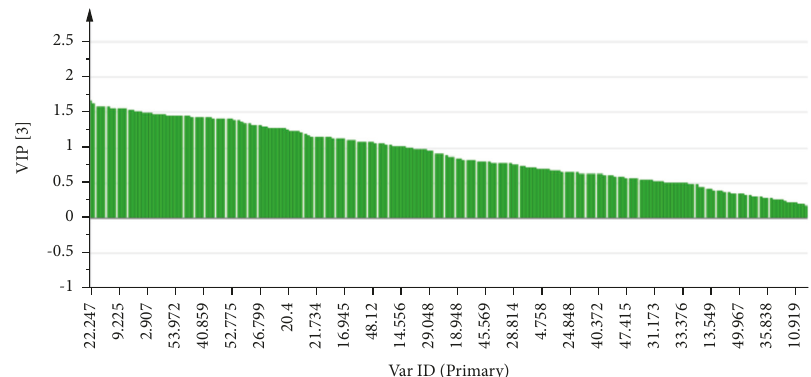
Figure 12: VIP of 218 chromatographic peaks in OPLS-DA model of Acacia catechu